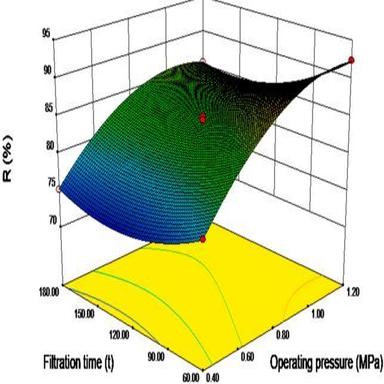
Response surface plot of the rejection to total soluble salts vs. the operating pressure and filtration time.